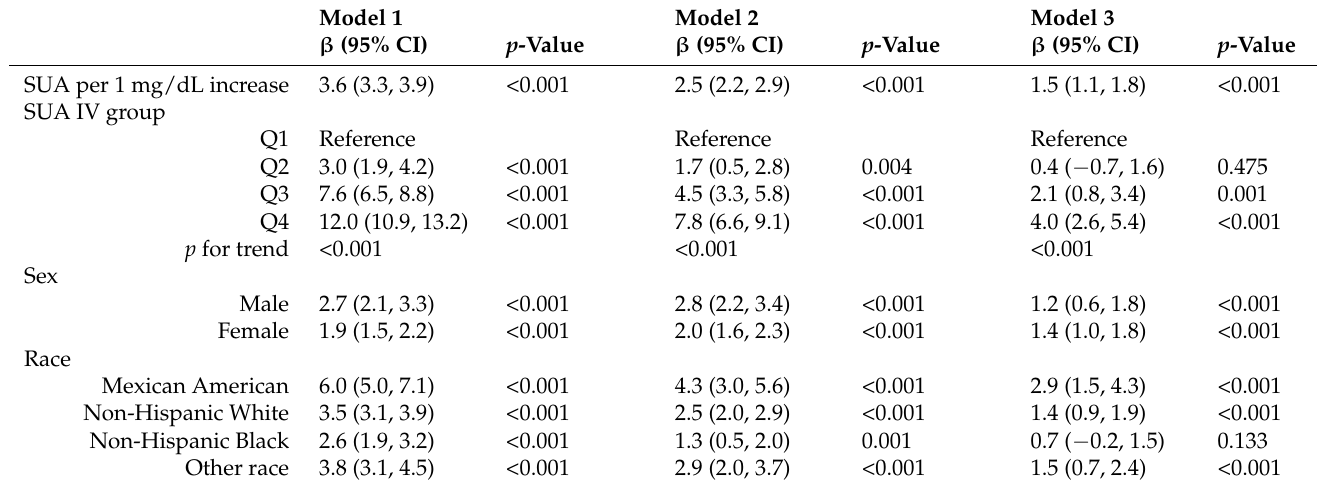
Table 3. The relationship between serum uric acid (mg/dL) and alanine aminotransferase